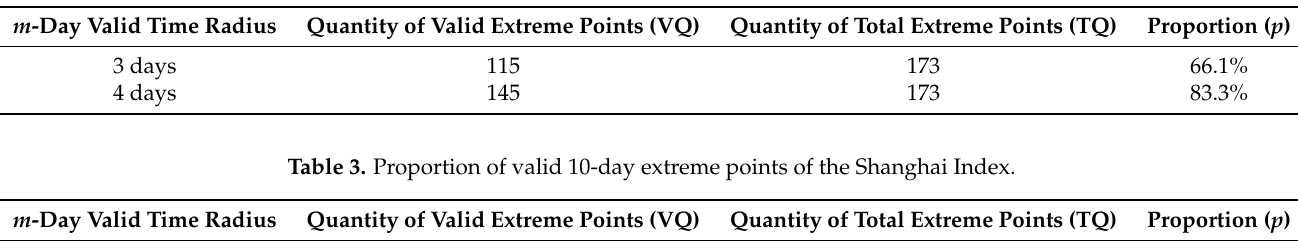
Table 2. Proportion of valid strong turning points of the Shanghai Index.